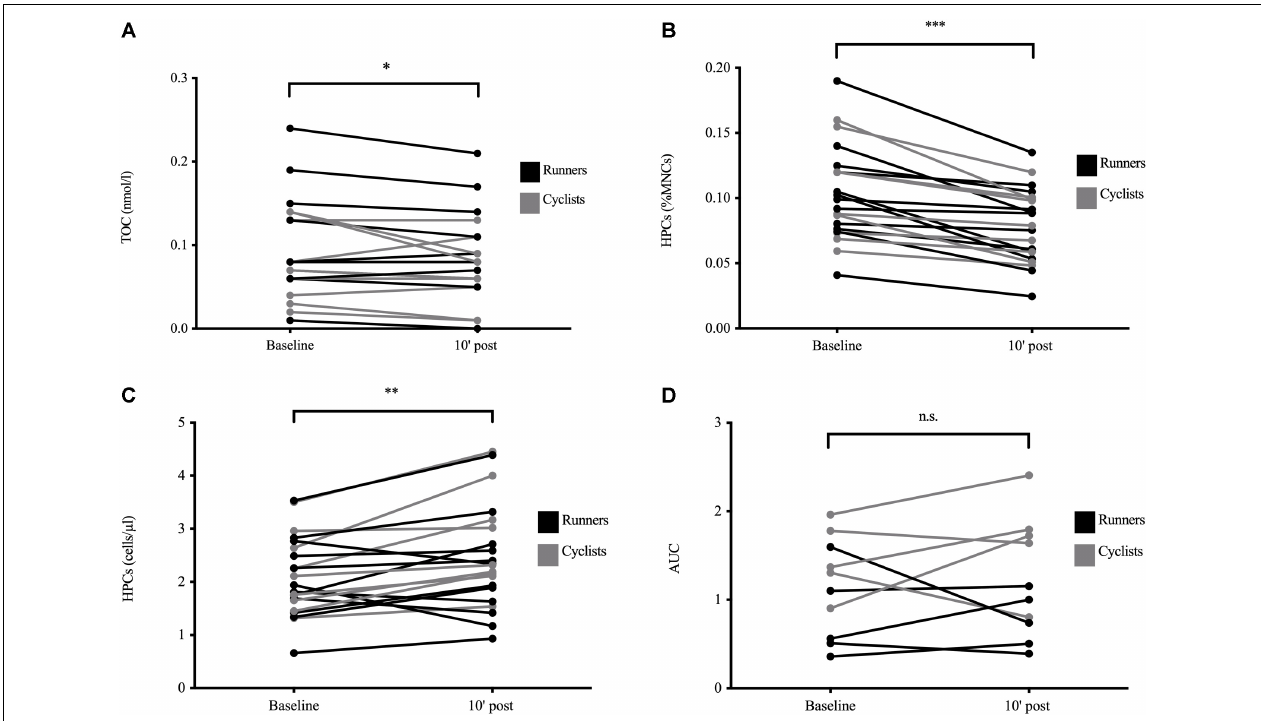
FIGURE 2 | Exercise-induced blood and serum parameters in well-trained participants. Total oxidative capacity (TOC, n = 20, A ), circulating hematopoietic stem and progenitor cell (HPC) proportions as percentage of acquired mononuclear cells (MNCs) assessed by flow cytometry ( n = 21, B ), HPC concentrations calculated by multiplying HPC proportions with the respective MNC numbers from the hemocytogram ( n = 21, C ), and secondary colony formation defined by the cells’ prolonged clonogenicity in vitro ( n = 10, D ) at baseline and 10 min after exercise cessation. Color differences indicate the two different exercise modalities. Significant differences between time points are indicated by * p < 0.050, ** p < 0.010, and *** p < 0.001; n.s., non-significant. Analysis was done by mixed ANOVA with one repeated factor (time) and one group factor (exercise